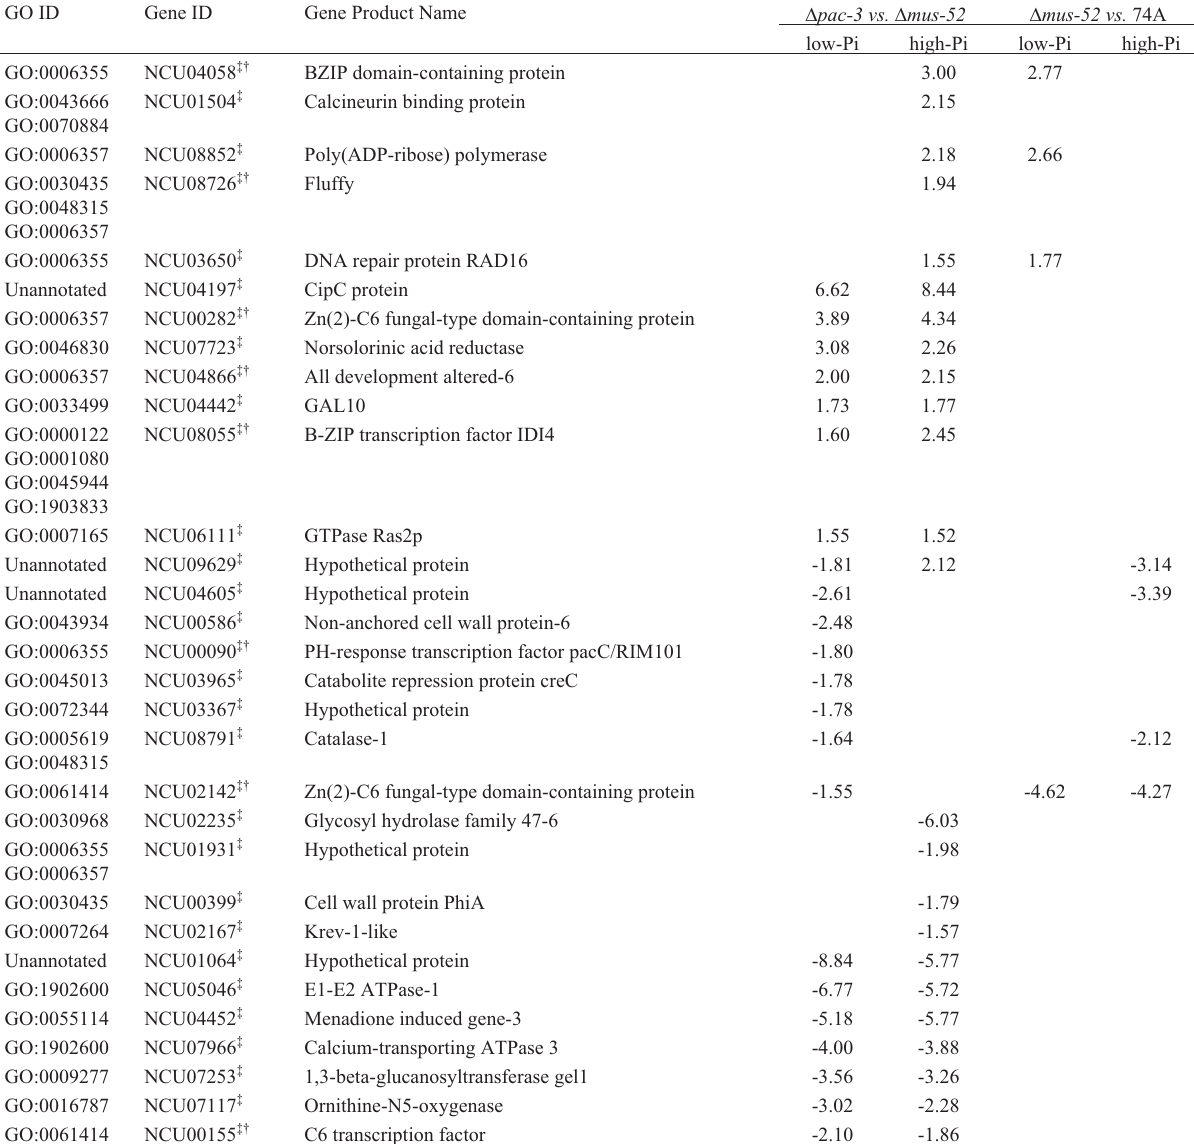
Table 1 - Genes of N. crassa modulated in response to low-Pi or high-Pi concentrations. Comparisons were made for the double mutant (cid:2) pac-3 strain considering the (cid:2) mus-52 strain as control (Martins et al. , 2019) and for (cid:2) mus-52 strain considering the St.L.74-OR23-1VA strain as control (Martins et al. ,2018).Theselectedgenesareassociatedwithmorphologyanddevelopmentregulation,includingtheGeneOntologydescendantssearchofthenodes “cell wall,” “developmental process,” “cellular developmental process,” “regulation of biological process,” and “anatomical structure